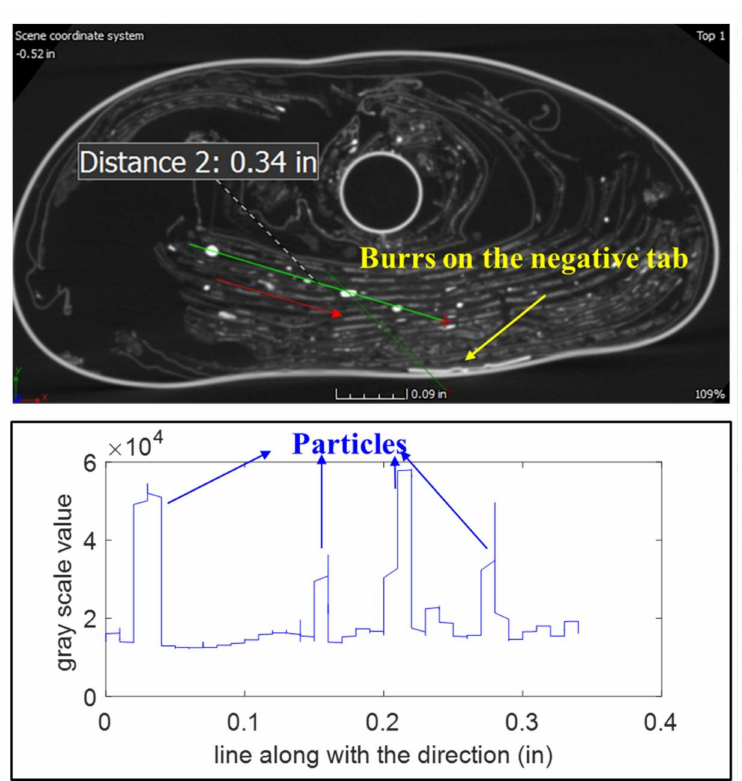
Figure 11. Area of interest of the sample A1 and the gray-scale profile along the marked green